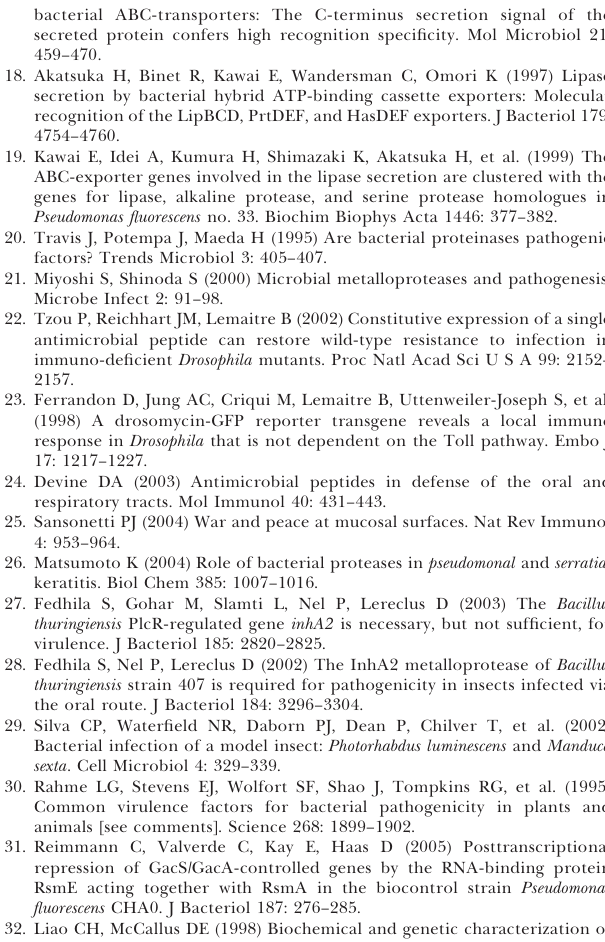
Figure S2. Over-Expression of Imd in the Gut Protected against P. entomophila whereas Its Activation in the Fat Body Did Not (A) Over-expression of an UAS-imd construct with the gut-specific driver caudal-Gal4 protects flies from an oral infection with P. entomophila. No protection was observed when the fat body driver pumpless-Gal4 was used . Log-rank analysis demonstrated a statistically significant difference in survival of wild-type flies and flies over- expressing an UAS-imd construct in the gut after oral infection with P. entomophila ( p , 0.0001). (B) Diptericin expression measured by RT-qPCR in Drosophila gut extracted from flies used in (A). A high Diptericin expression was observed in the gut of flies carrying both the UAS-imd and the caudal- Gal4 constructs. Figure S3. Expression of AMP Genes (A) Diptericin expression measured by RT-qPCR in Drosophila gut extracted from wild-type and Rel males following natural infection with P. entomophila . Over-expression of an UAS-Relish with the caudal- Gal4 driver restores the immune inducibility of the Diptericin gene. Diptericin expression was normalized to rp49 mRNA. 100% value corresponds to the level of Diptericin mRNA obtained after infection of wild-type flies with P. entomophila . rp49 : ribosomal protein 49 . (B) The quantification of AMP gene expression shows that imd flies carrying two UAS-AMP insertions and da-Gal4 constitutively express the UAS-AMP fusion at a high level. AttA (left) and Dpt (right)